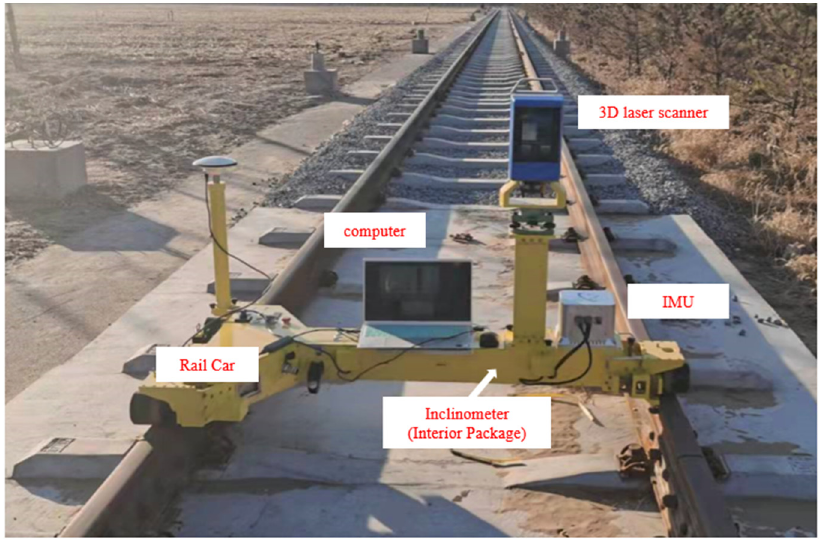
Figure 3. Track Mobile Laser Measurement System (TMLS).